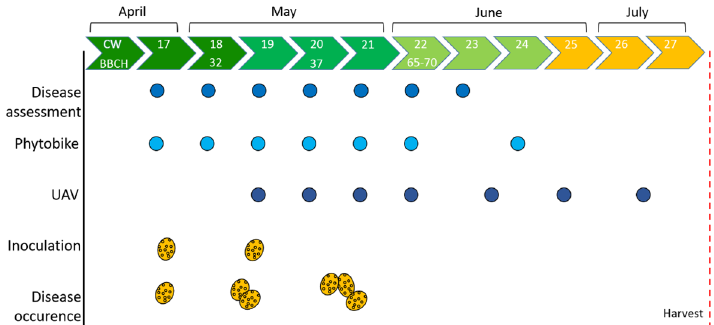
Figure 2. Schematic overview of the course of the 2018 vegetation period. For each calendar week, the actions are presented and disease occurrence of yellow rust (YR) is shown. Weekly assessments and measurements were performed during the vegetation period (CW = calendar week; BBCH = growing stage).